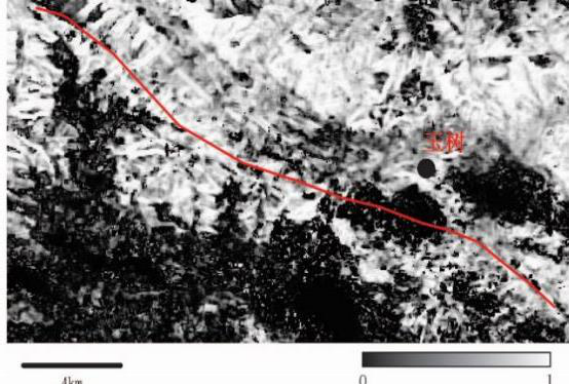
Figure 7. SNR map of Co-seismic displacement field (The red line is the co-seismic surface rupture